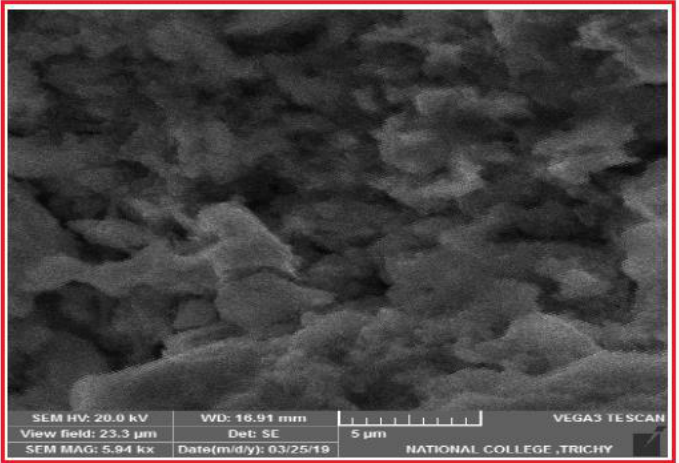
Figure 8. Corroded areas showing many pits.